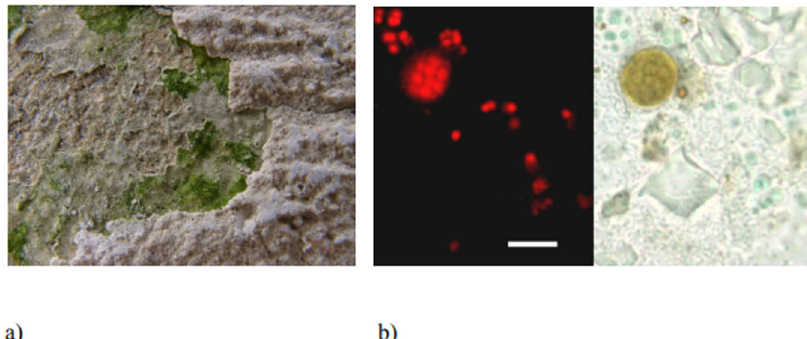
Fig. 4 Endoliths. Endolithic cyanobacteria growing within sandstone. In a , which is shown at approximately half-size, the green growth is seen; in b , the brown and green cells within the pulverised fl ake of stone are visualised under the light microscope and as auto fl uorescent red cells (indicating the presence of chlorophyll) under UV light. Bar marker = 10 μ m.